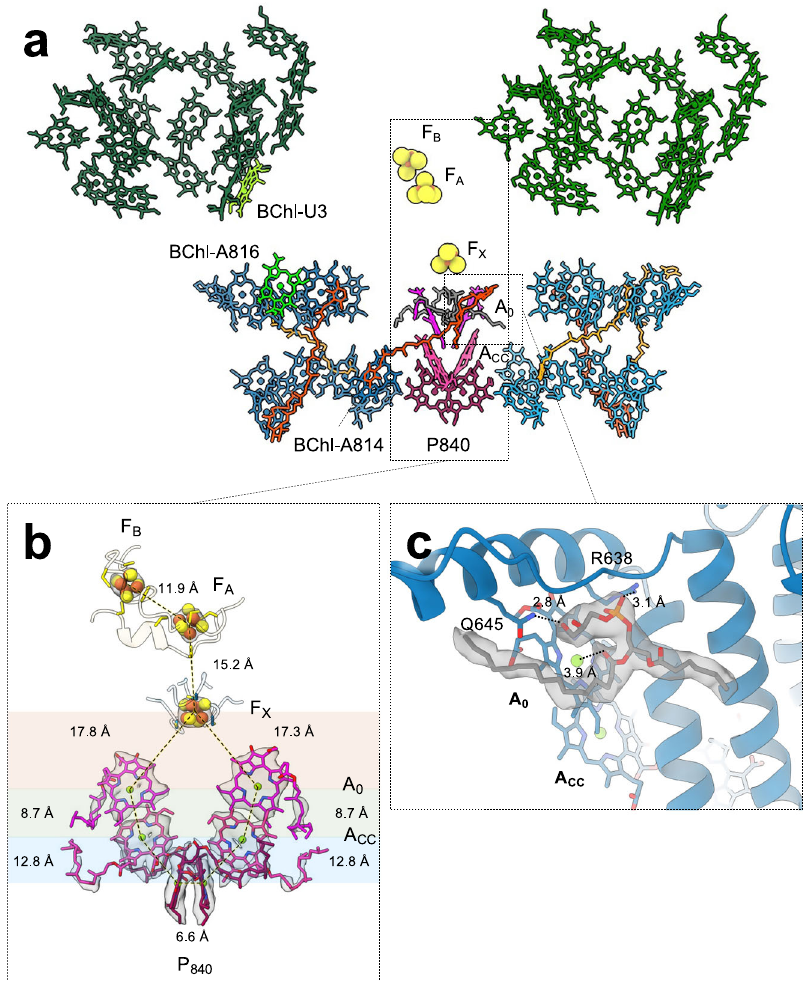
Fig. 4 | Pigment distribution in the RC-FMO 2 photosynthetic supercomplex. a BChl a molecules are colored in dark green (FMO1), forest green (FMO2), blue (PscA1),and light blue (PscA2).BChl-U3 and BChl-A816 arecolored in green yellow andlightgreen,respectively.PigmentsforP840,A 0 ,andA CC centersarecoloredin purple, darkpink,and magenta, respectively. F39 and F26 carotenoids are colored in orange red and orange sticks, respectively. The central F39 carotenoid at the PscA dimer interface has a tilt angle of 54° to the normal of the membrane plane. Two phosphatidyl glycerol (PG) lipids near A 0 are shown in gray sticks. Iron-sulfur